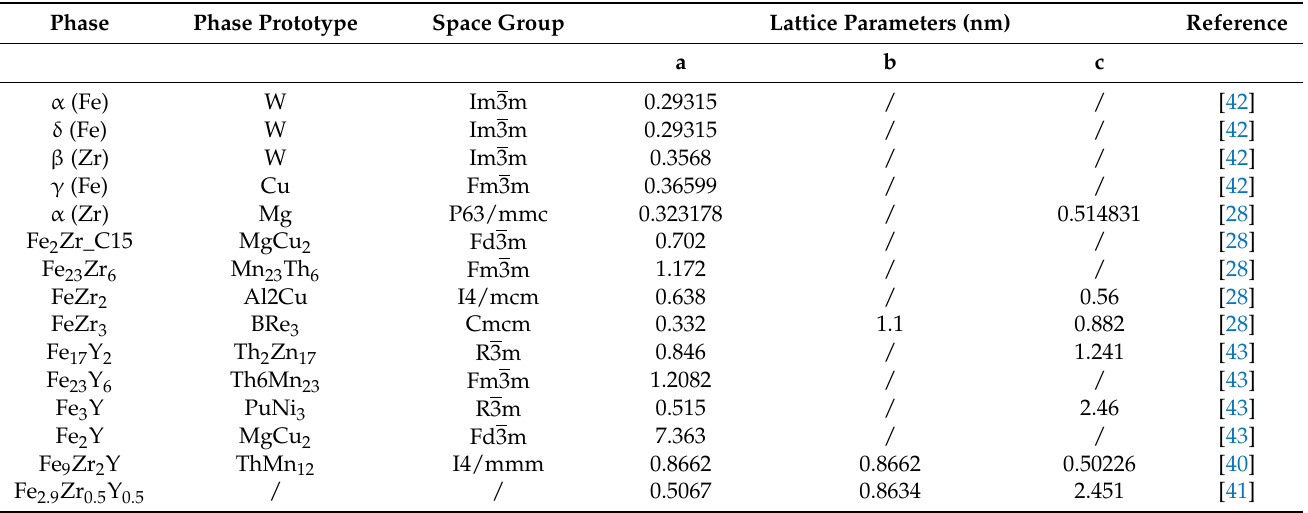
Table 1. Experimental and literature data on crystal structures and lattice parameters of the solid phases in the Fe-Zr-Y